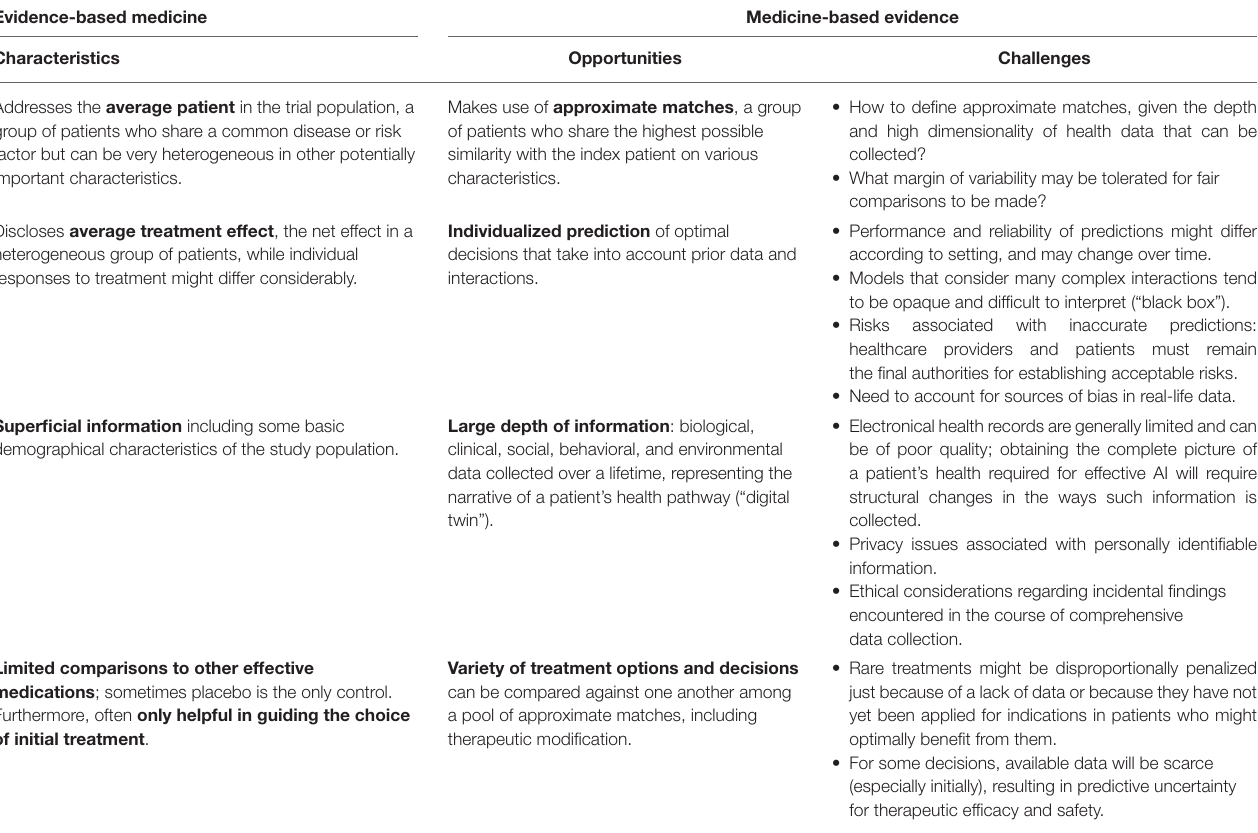
TABLE 1 | Opportunities and challenges when transitioning from evidence-based medicine to medicine-based evidence. Evidence-based